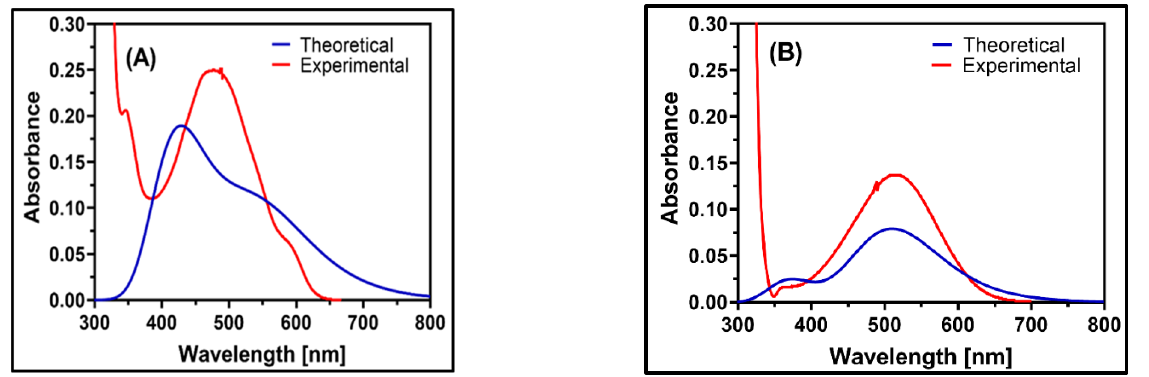
Figure 10. The experimental and theoretical UV spectra of: ( A ) LGN–DDQ (1:1) 1 × 10 –4 M and ( B ) LGN–CHA (1:1) 1 × 10 –4 M. Table 3. UV–Vis band gap energy E (eV) and oscillator strength ( f ) for the LGN-DDQ and LGN-CHA molecule calculated at TD-DFT/B3LYP method using MeCN solvent.